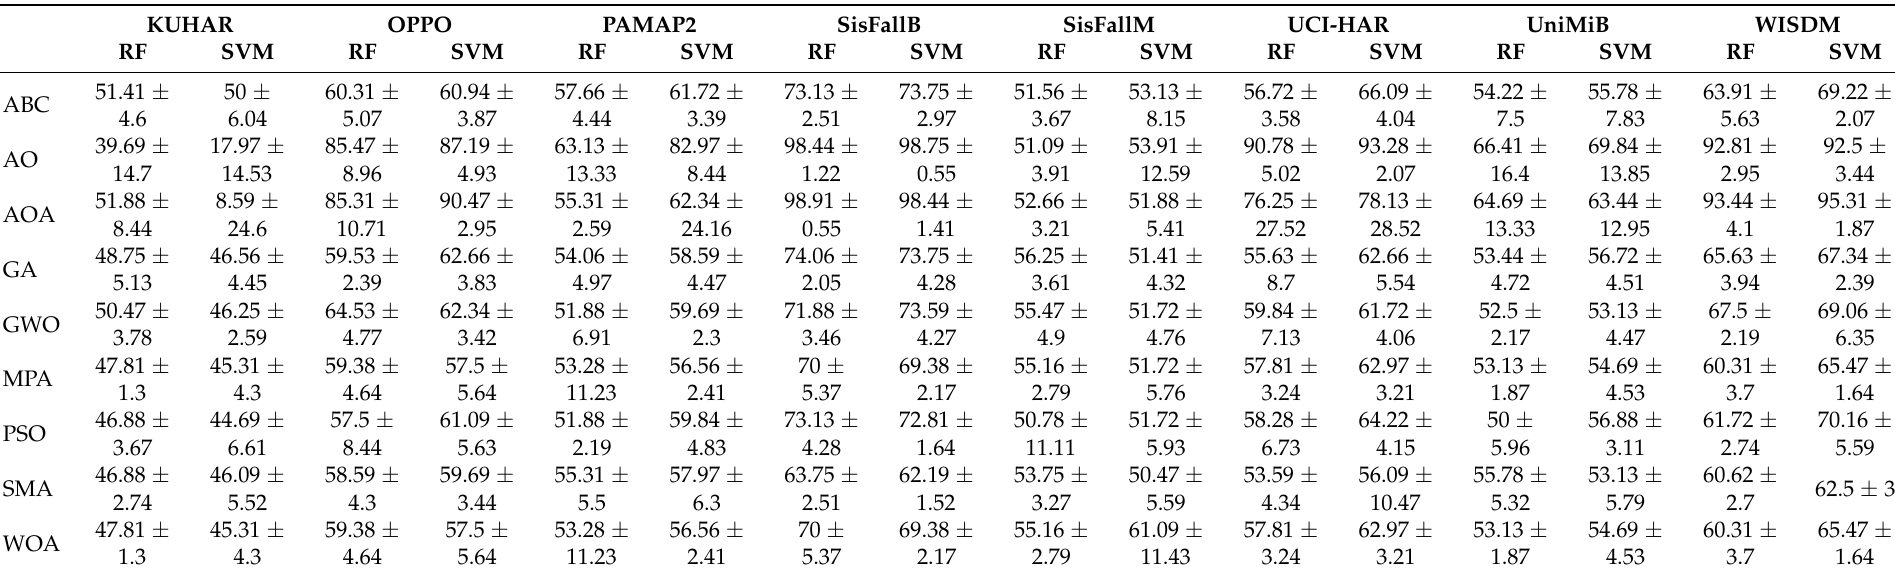
Table 4. Average percentage of feature reduction (%) of applied MH